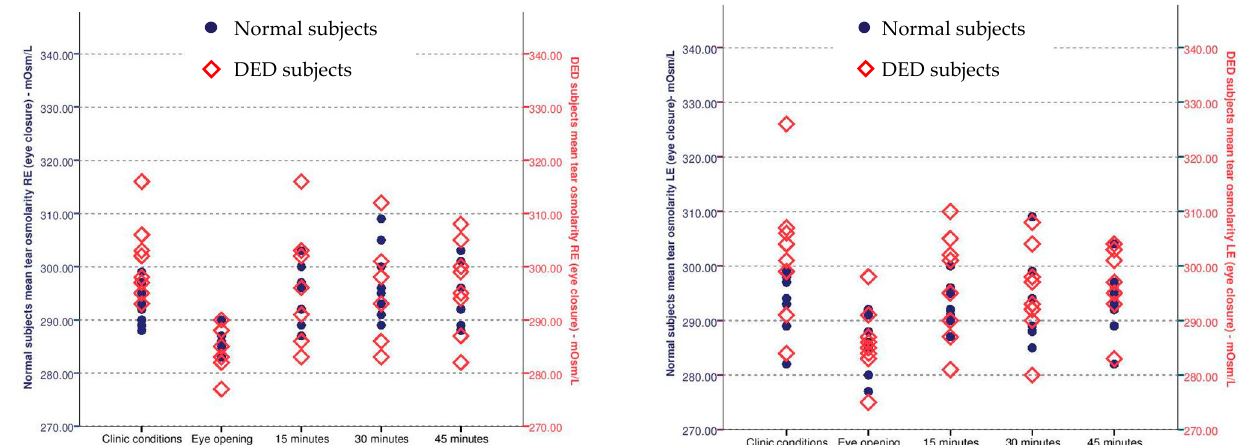
Figure 4. ( left ). Scatterplot displaying mean tOsm values for normal and Dry eye disease (DED) subjects RE after 45 min of eye closure and then every 15 min with eyes open at 45% relative humidity (RH). ( right ). Scatterplot displaying mean tOsm values for normal and DED subjects LE after 45 min of eye closure and then every 15 min with eyes open at 45% RH (Reprinted with permission from ref. [11]. Copyright 2021 Anglia Ruskin University ARU)